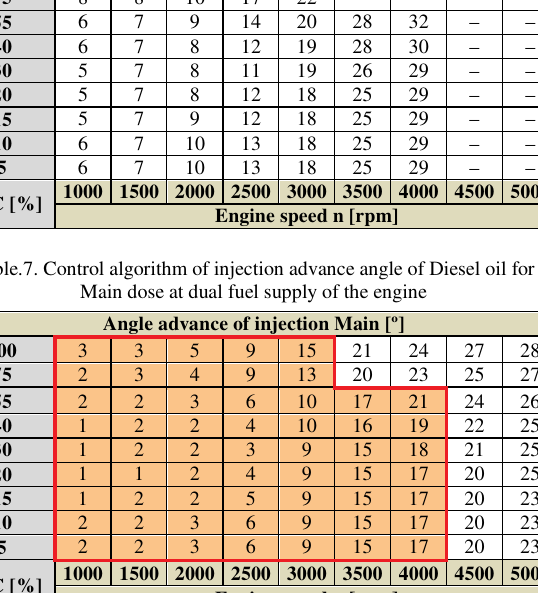
Table 6. Control algorithm of injection advance angle of Diesel oil for Pre dose at dual fuel supply of the engine Angle advance of injection Pre [º] 100